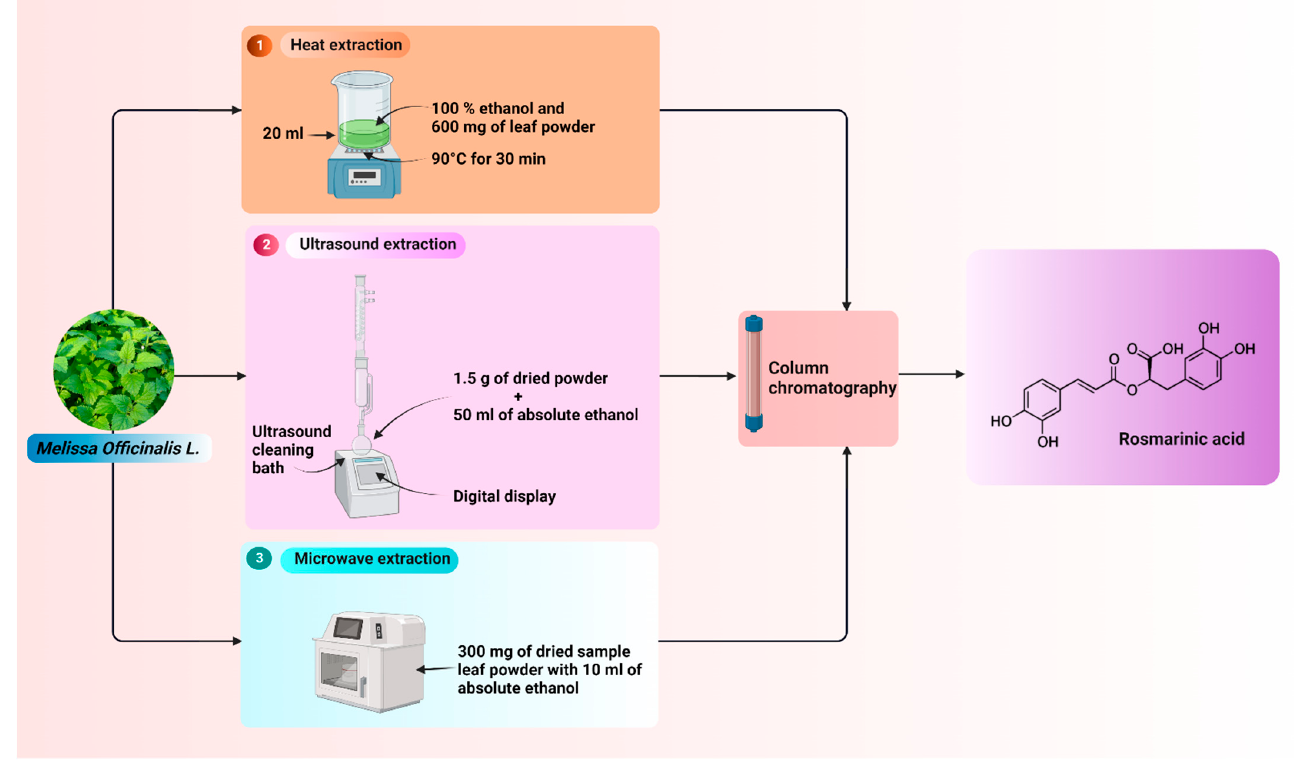
Figure 2. Various extraction and isolation methods of